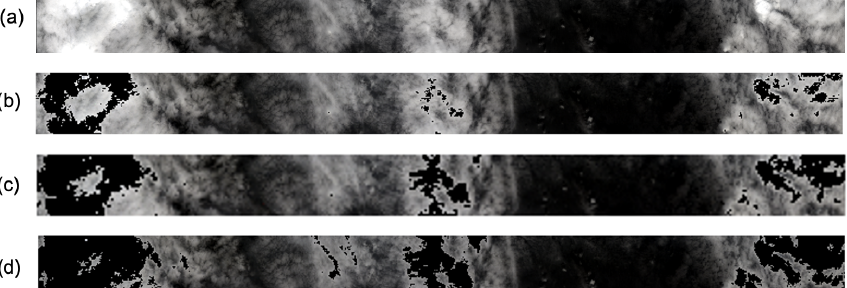
Figure 5. An example of pixels classified as cloudy being excised from a Hyperion image (EO1H1940712011304110T1). These images were created using the default RGB wavelengths in the ENVI program, although the algorithm to create the panels in this figure only considers the three wavelengths used in our thresholds. The panels show the following: (a) the raw image with no screening, (b) cloud screening with α FP = 1000 where 8.5% of the total pixels were excised, (c) cloud screening with α FP = 100 where 16.4% of the total pixels were excised, and (d) cloud screening with α FP = 10 where 25% of the total pixels were excised. Note this is an example of excision in a particular scene. Our training set was intentionally designed to capture opaque clouds and to pass ambiguous or translucent cloud